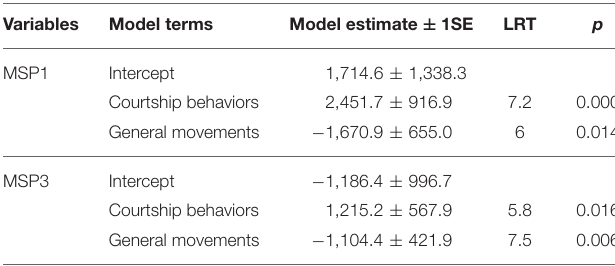
TABLE 3 | Summary of models testing for the effect of courtship behaviors and general movements on MSP1 and MSP3 headspace amounts, where male and female age were used as random